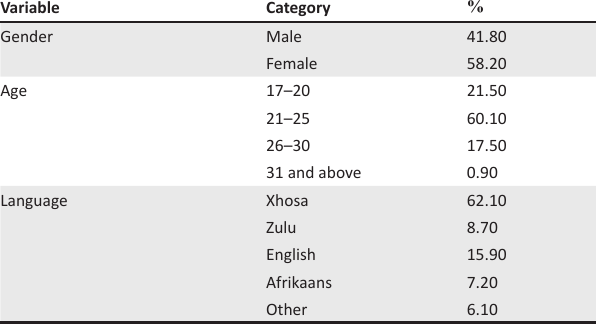
TABLE 2: Demographics of respondents ( n = 447).